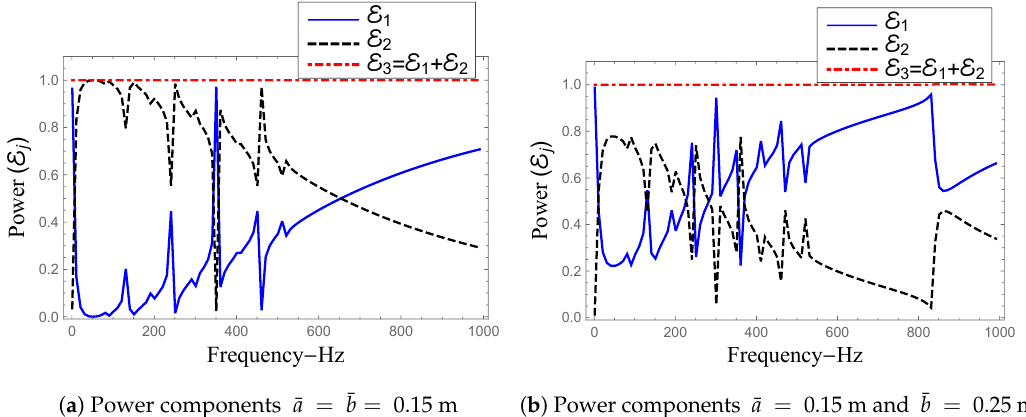
( b ) Power components ¯ a = 0.15 m and ¯ b = 0.25 m Figure 8. Scattering powers against